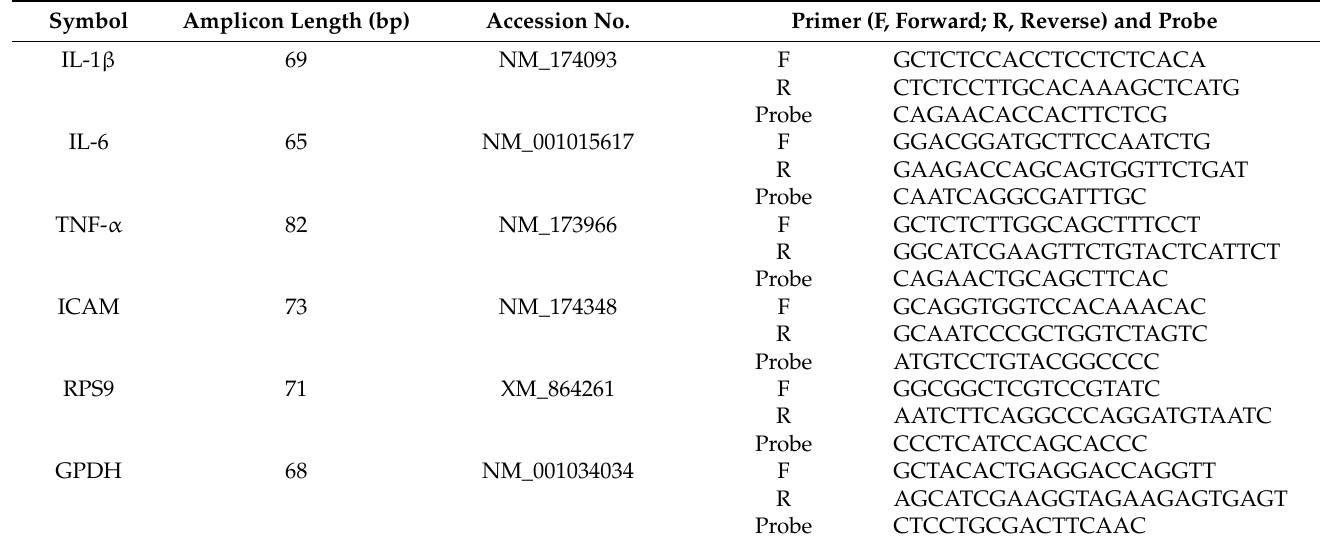
Table 2. Custom bovine primer/probe sets used for reverse